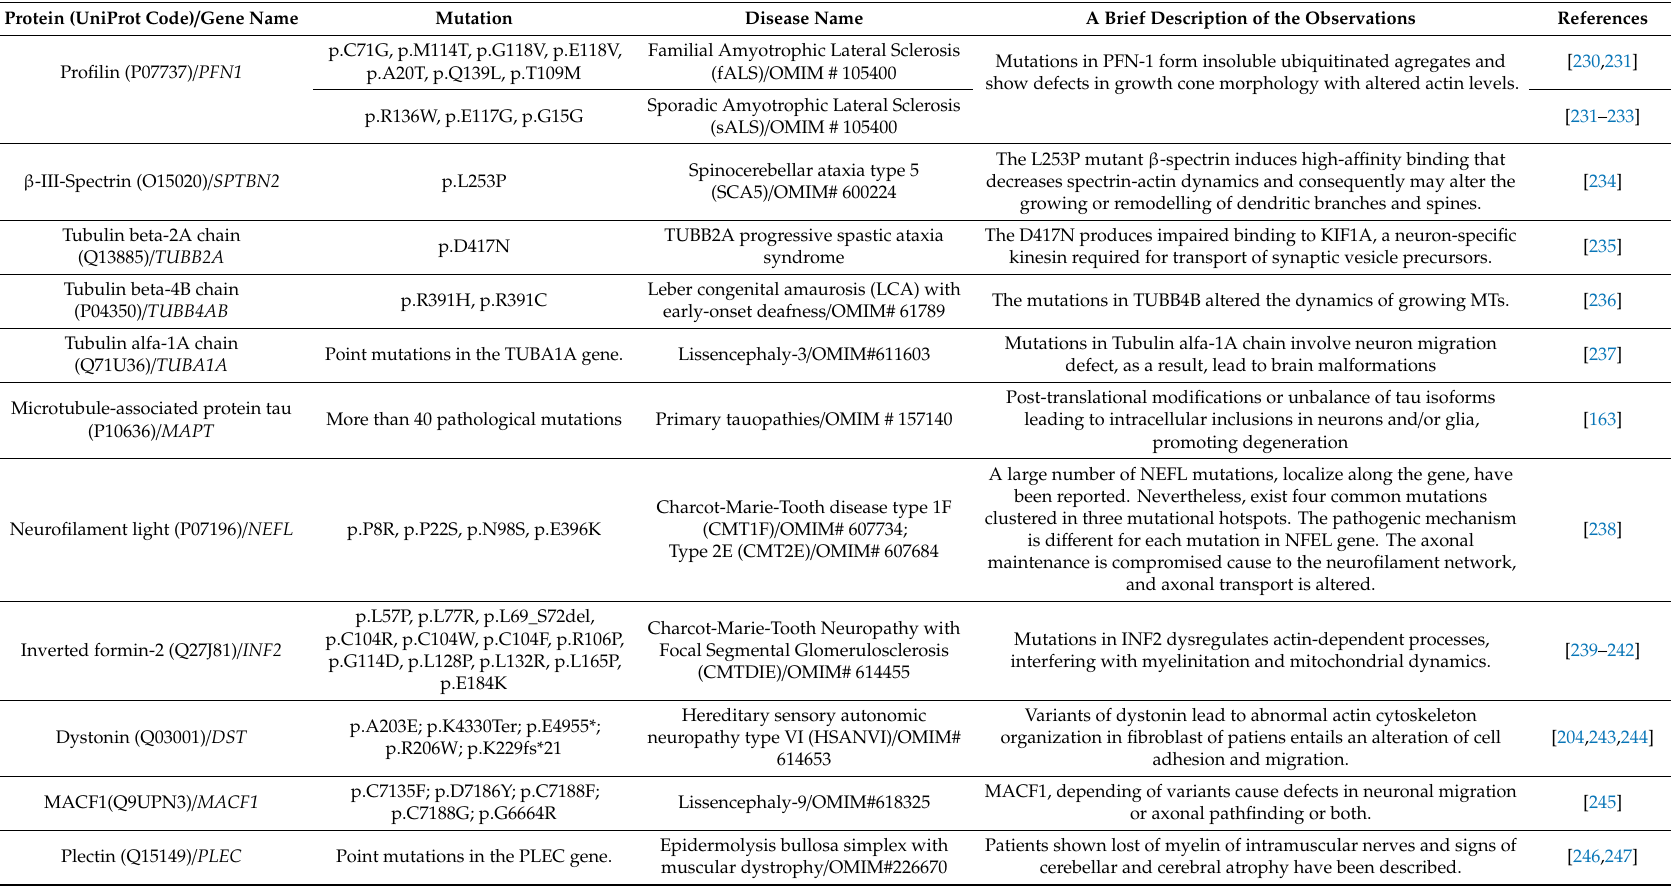
Table 2. Cytoskeletal proteins and their mutations associated with neurological diseases as primary